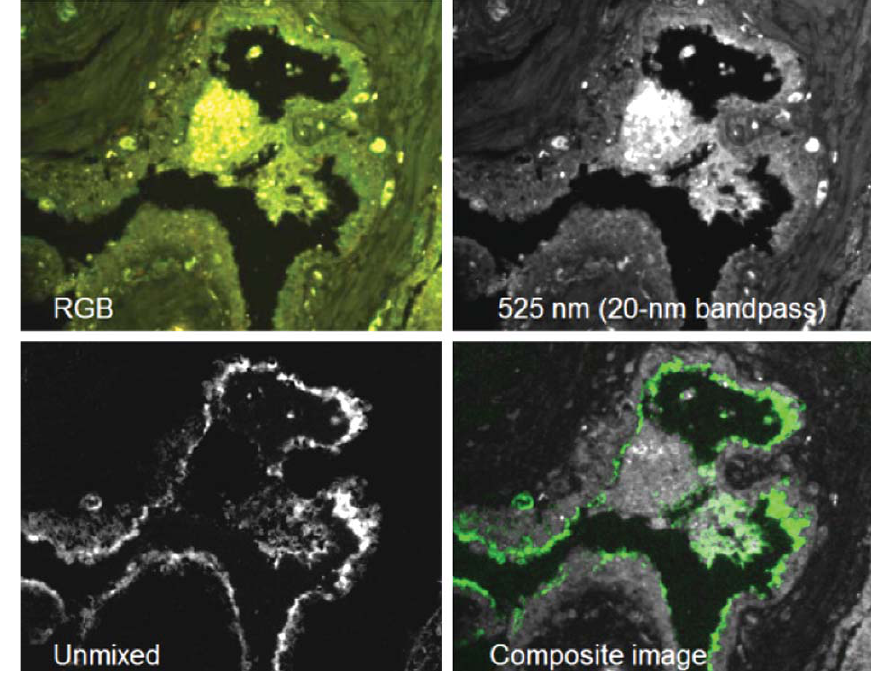
Fig. 3. Removal of autofluorescence reveals dim